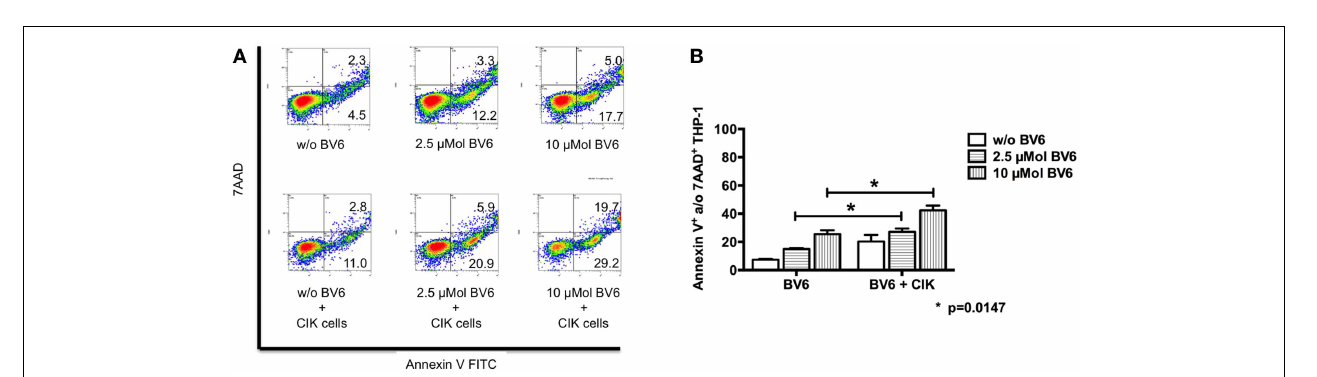
Analysis of apoptotic (AnnexinV FITC) and necrotic cells (7AAD) showed that combination therapy increased cytotoxicity against CD33-expressing larger THP-1 cells. Cytotoxicity data (AnnexinV- and/or 7AAD-positiveTHP-1 cells) from three independent experiments shown as mean ± SEM